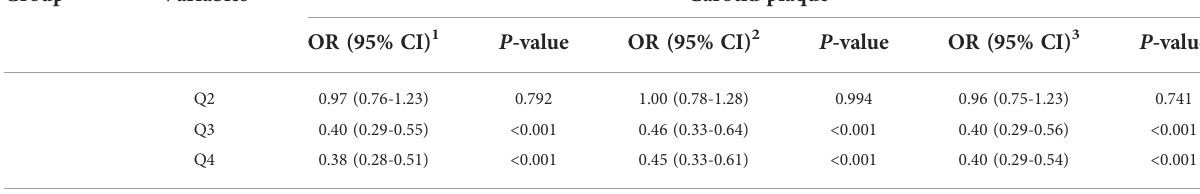
density lipoprotein cholesterol; LDL-C, low-density lipoprotein